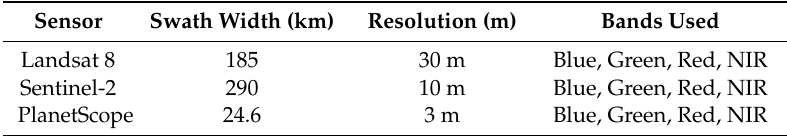
Table 1. Sensors used in the visual shoal detection of the Northern Low-Impact Shipping Corridors.